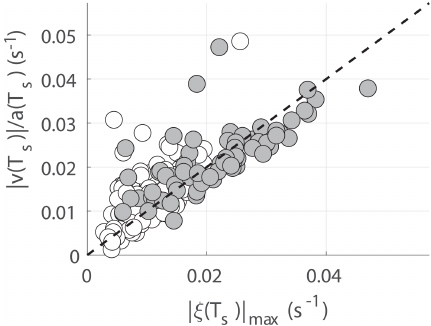
Figure 13. The theoretical velocity shear v/a plotted against the absolute value of the vorticity in the vortices at separation time. Straits with self-propagating dipoles are marked in gray.